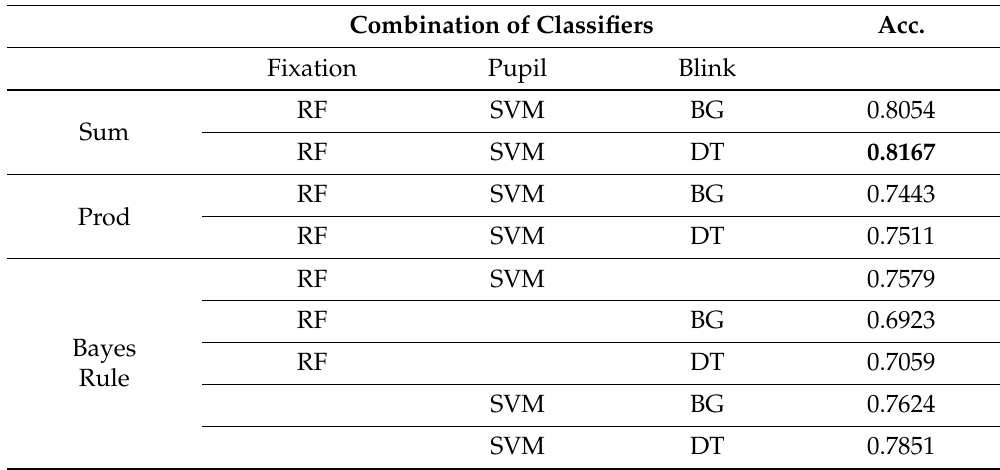
Table 6. The results of the combination of the classifiers in gender recognition using different transformation-based score techniques without a a preliminary feature level fusion. The numbers in bold are the best